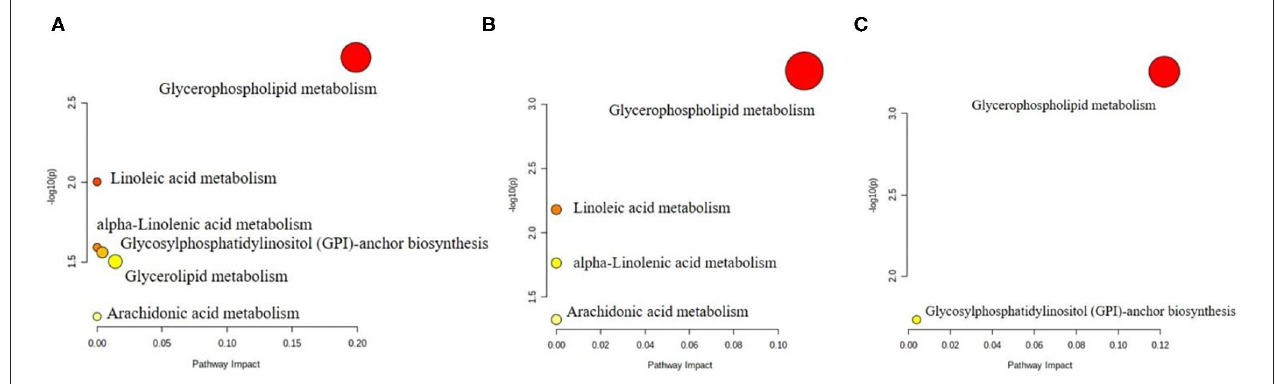
FIGURE 4 | Pathway analysis of differential lipid metabolites in liver from the (A) LG group, (B) MG group, and (C) HG